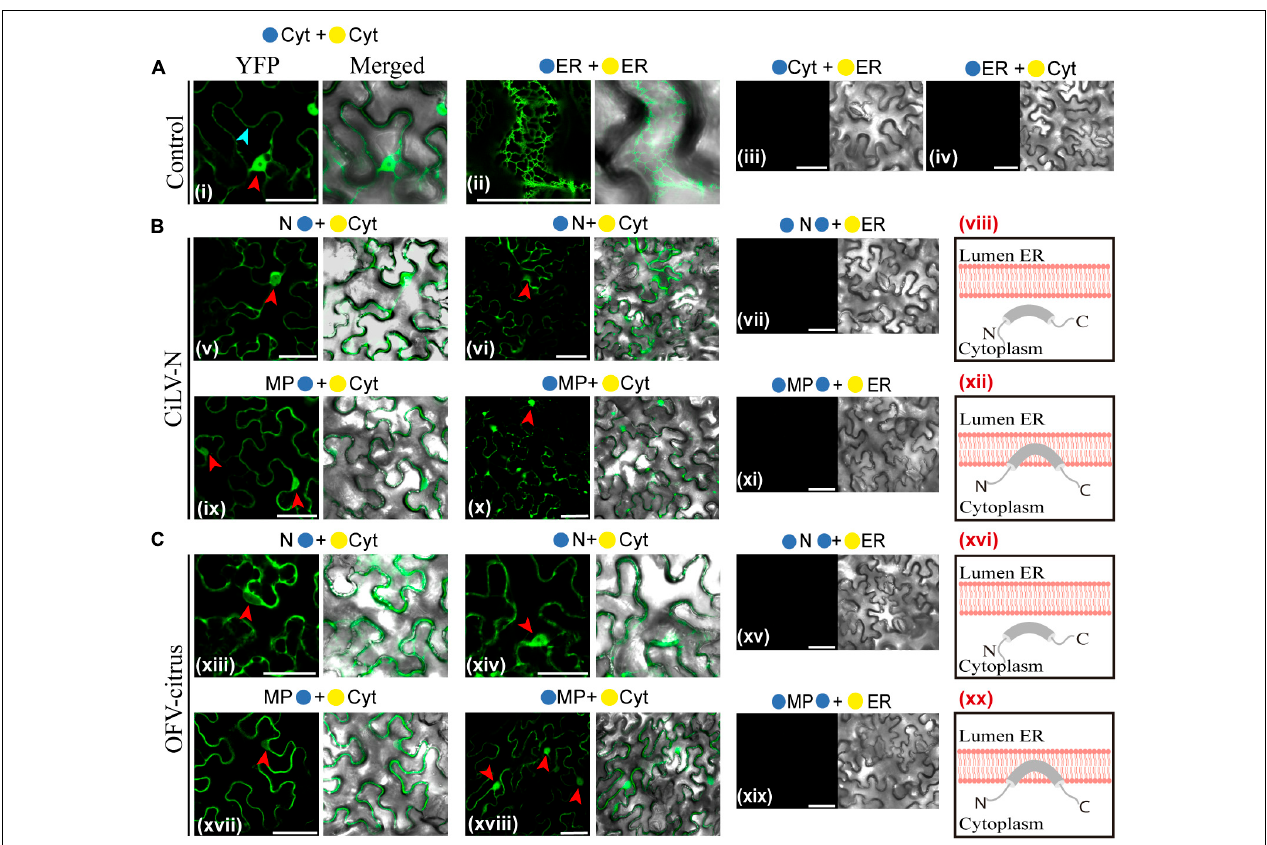
FIGURE 2 | Dichorhavirus MPs are associated to membrane with their termini exposed to the cytosol. Subcellular localization (cytosolic face or ER lumen) of the N- or C-termini of the CiLV-N N, MP (B) and OFV-citrus N, MP (C) . All proteins carrying the N-terminal ( • ) or C-terminal ( • ) YFP fragments fused at their N-( • / • -ORFs) or C-termini (ORFs- • / • ) were transiently co-expressed in N. benthamiana leaves with corresponding complementary YFP fragment addressed to the cytosol face ( • -cyt or • -cyt) or the lumen of the ER ( • -ER or • -ER). Images reveal the topology of the C-termini (v,ix,xiii,xvii) or N-termini (vi, x, xiv, and xviii) of the respective dichorhavirus proteins. Red and blue arrows indicate the cell nucleus and cytoplasm, respectively. Positive and negative controls are presented in (A) . Hypothetical topologic models are presented at the panels to the right of the figure for each respective protein (viii,xii, xvi,xx). All images contain two pictures corresponding to the YFP signal or merged with bright field. The fluorescence was monitored at 4 days post-infiltration using a confocal Zeiss LSM 780 model. Bars correspond to 50 µ